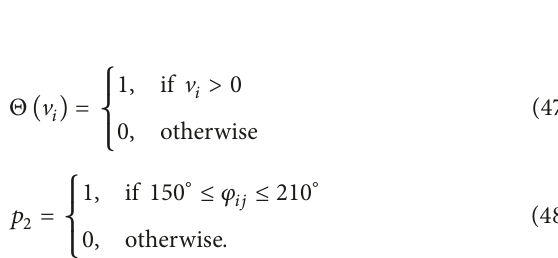
Figure 9: Conflict avoidance mechanism of